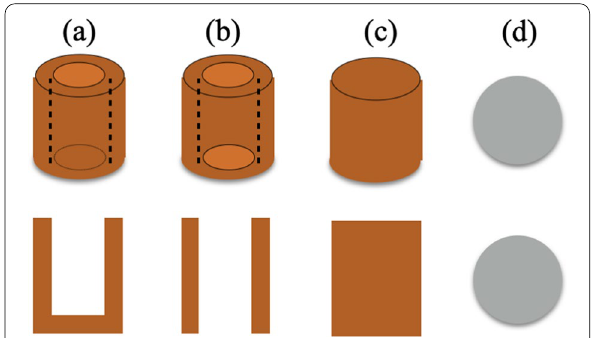
Fig. 1 The shape of the projectiles used in our experiments: a a closed tube, b an open tube, c a solid cylinder, and d a solid sphere. The lower figure shows the cross section of each projectile. The projectiles are all fabricated from copper, except for the solid spheres, which are made of